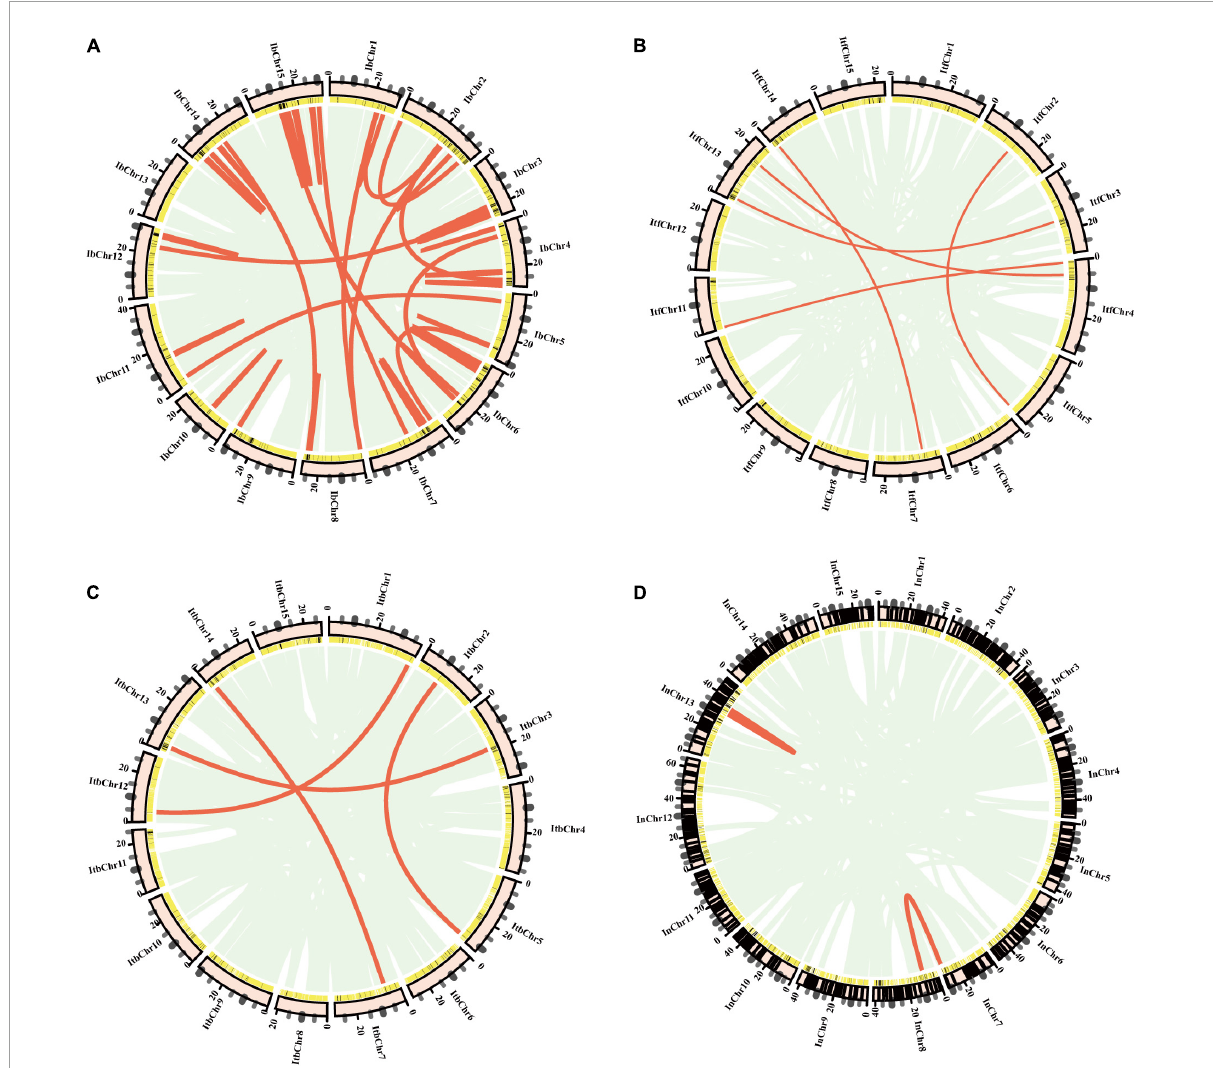
FIGURE4 Collinear gene pairs for I. trifida nucleotide-binding site (NBS) genes on 15 chromosomes of four Ipomoea species: (A) I. batatas ; (B) I. trifida ; (C) I. triloba ; (D) I. nil . The outer circle represents the haploid chromosomes (light pink); the second circle represents the matches of the genes with the genome of (NBS-encoding genes: black; non-NBS-encoding genes: yellow). Red lines show the collinear gene pairs for NBS-encoding